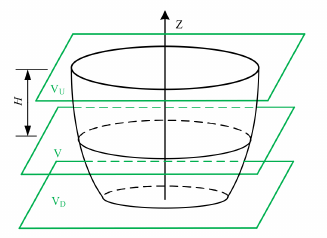
Figure 6. Construction of the cutting surface.